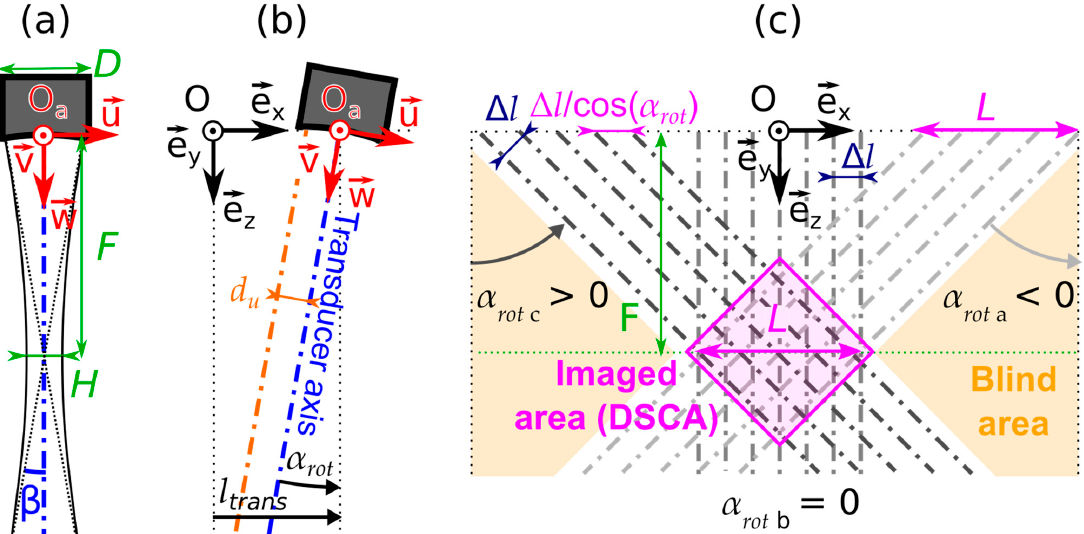
Figure 1. Schematic diagram of the scanning scheme in 2-D. ( a ) One weakly focused transducer array element of width D and focal distance F . H is the pulse-echo full-width half-maximum (FWHM) of the ultrasound beam. The angular full aperture is 2. β . The angle bisector is named transducer axis. A Cartesian coordinate system is attached to the transducer element face: u corresponds to the elevation direction and w to the axial direction. For a linear array, the long axis along the row of its active array elements (lateral direction) is the v -axis. The origin O a is the center of the transducer element face; ( b ) the transducer element at one tomographic position. For the fixed Cartesian coordinate system, the vectors e y and e z correspond to the rotation axis and the radial direction, respectively, when the rotation angle α rot equals zero. The translational axis of the scan is e x . For the diagrammed position, the rotation angle is α rot (here α rot < 0) and the translation position relative to the origin O is l tran s . The distance d u is a distance to the transducer axis in the elevation direction used during the reconstruction process. ( c ) The transducer axis is shown for several positions of the scanning process. The translation positions are illustrated for three different rotation angles: α rot a, α rot b, and α rot c . For each angle α rot , the translation ranges from l trans center ( α rot ) − L/2 to l trans center ( α rot ) + L/2. For two successive positions at a constant α rot , the spacing between the transducer axes is ∆ l and the transition step is ∆ l /cos( α rot ) along the translation axis. The magenta square indicates the imaged area, i.e., the region probed with all the different orientations of the transducer axis. This area is named DSCA for Diamond-Shaped, Cross-sectional